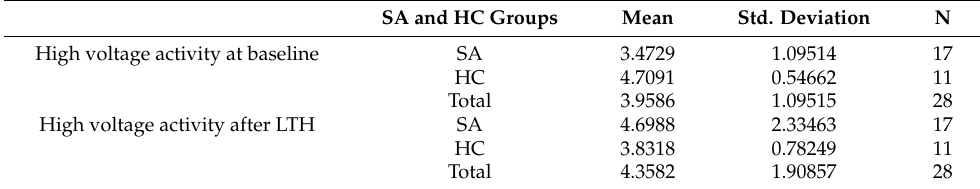
Table 12. Descriptive Statistics for High voltage.